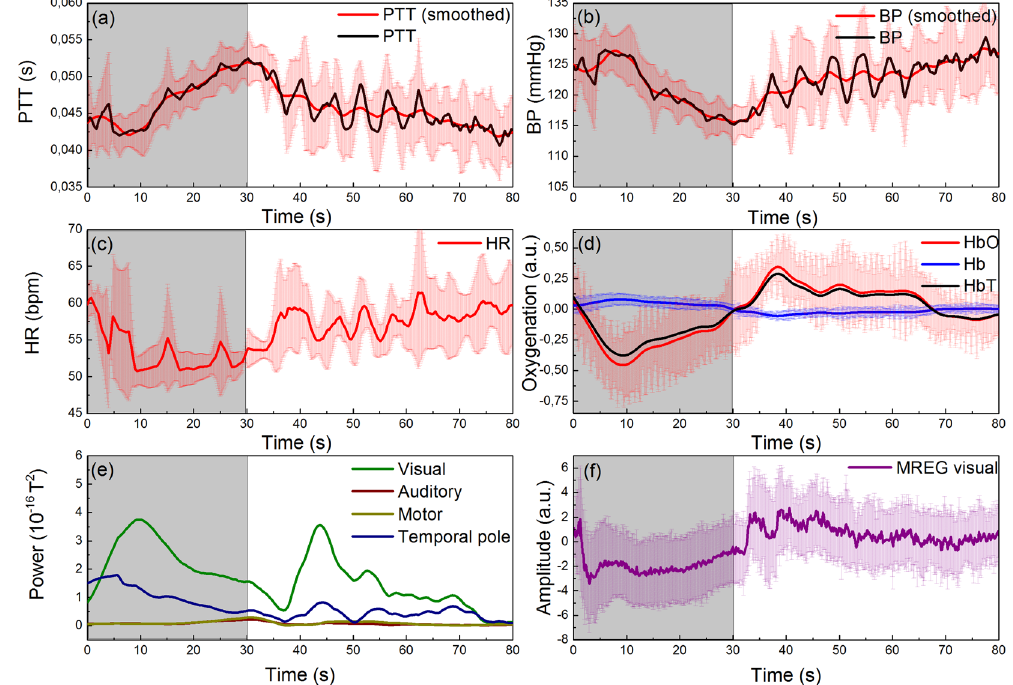
Figure 7. Averaged responses for PTT ( a ), BP ( b ), HR ( c ) measured with the cNIBP device; HbO/Hb ( d ) measured with the NIRS device from back of the head and four scouts (MEG) covering visual (green line), auditory (brown line), motor (dark yellow line) and temporal pole (blue line) brain areas ( e ). Average for NIRS and cNIBP data was calculated using values obtained during 4 breath holding sequences. Vertical bars represent standard deviation of the values. In addition, ( f ) shows an averaged response of 8 breath holds using the same breath hold task but recorded independently with our MREG multimodal setup 9 . In all subfigures t = 0 marks the beginning of breath holding for 30 s, highlighted with grey